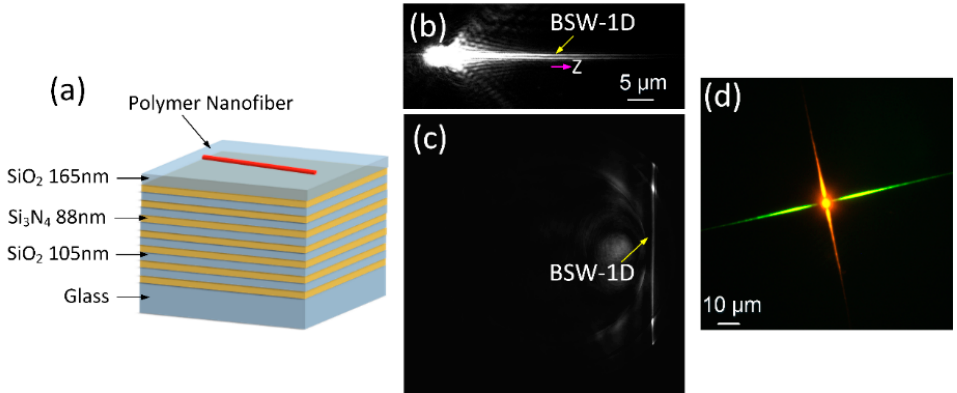
Figure 8. Optical waveguide of ultrafine polymer nanofibers on the surface of a multilayer dielectric film. ( a ) Diagram of the structure. ( b ) Front focal plane image of optical signal propagating along the polymer nanofiber. ( c ) Back focal plane image of optical signal propagating along the polymer nanofiber. ( d ) Fluorescence image of two crossed nanofibers that propagated light signals with different wavelengths ( Here the BSW is shorted for the Bloch Surface Wave, the whole Figure 8 was reprinted with permission from Wang et al. [50]).